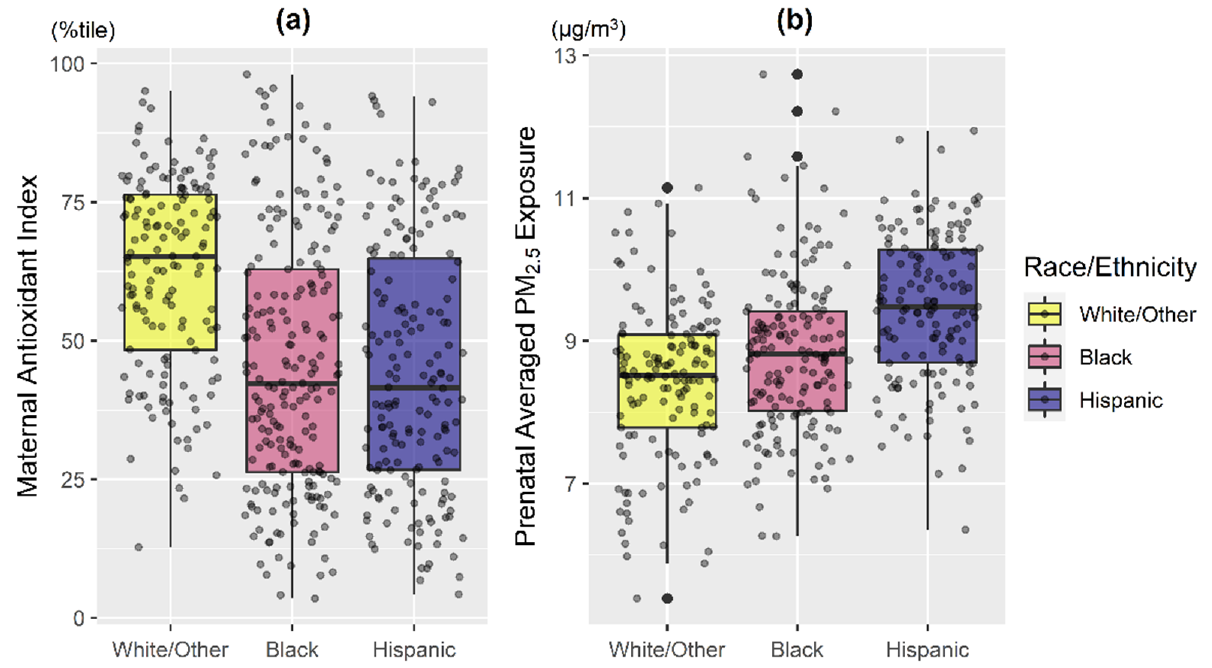
Figure 1. Distribution of maternal antioxidant intake and prenatal PM 2.5 exposure averaged across pregnancy by maternal race/ethnicity. Boxplots of ( a ) maternal composite antioxidant index and ( b ) prenatal PM 2.5 exposure averaged across pregnancy, stratified by maternal race/ethnicity (Black: Black/Hispanic Black; Hispanic: non-Blank Hispanic; White/Other: non-Hispanic White/other race). Bottom line and upper line of the box denote 25th percentile (Q1) and 75th percentile (Q3) of the distribution, while the thick line within the box denotes median. Lower and upper whiskers of the vertical line denote Q1 − 1.5*IQR and Q3 + 1.5*IQR, while the dark black dots represent potential extreme values. IQR: interquartile range. Kruskal–Wallis test indicated that maternal antioxidant index and averaged prenatal PM 2.5 among racial/ethnic subgroups are significantly different (both p < 0.001).